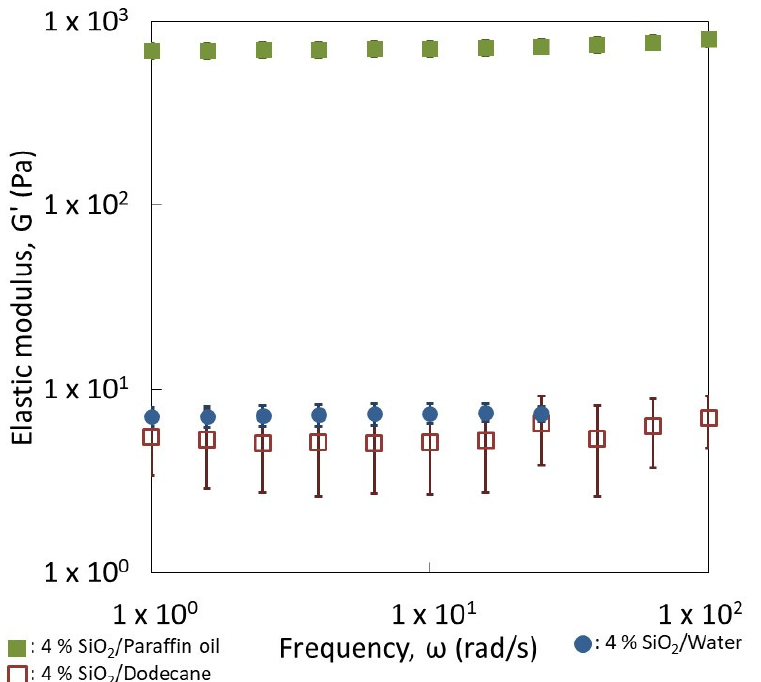
Figure 3. Rheological behavior of oily (dodecane and paraffin oil) and aqueous suspensions prepared with 4 wt.% of silica particles. Mechanical spectra showing the elastic modulus (G ′ ) as a function of frequency ( ω ).